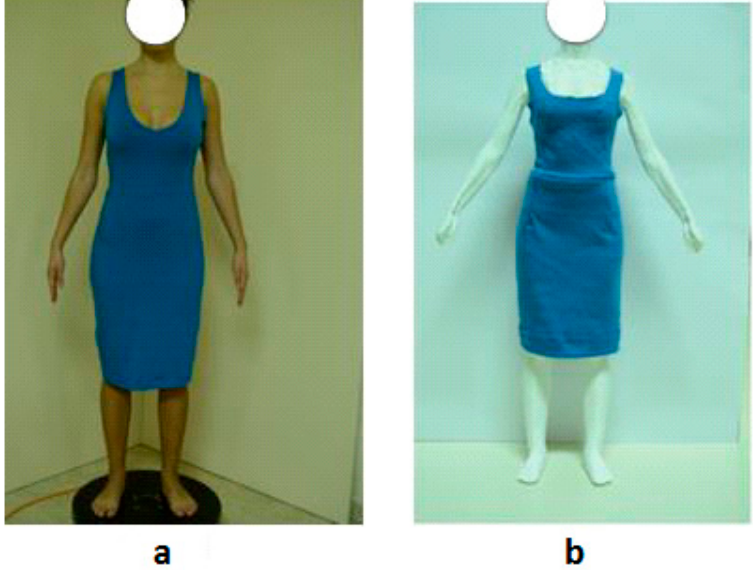
Figure 16. Testing garment fit over real body model ( a ) and the scaled 3D printed body model ( b ) [1].